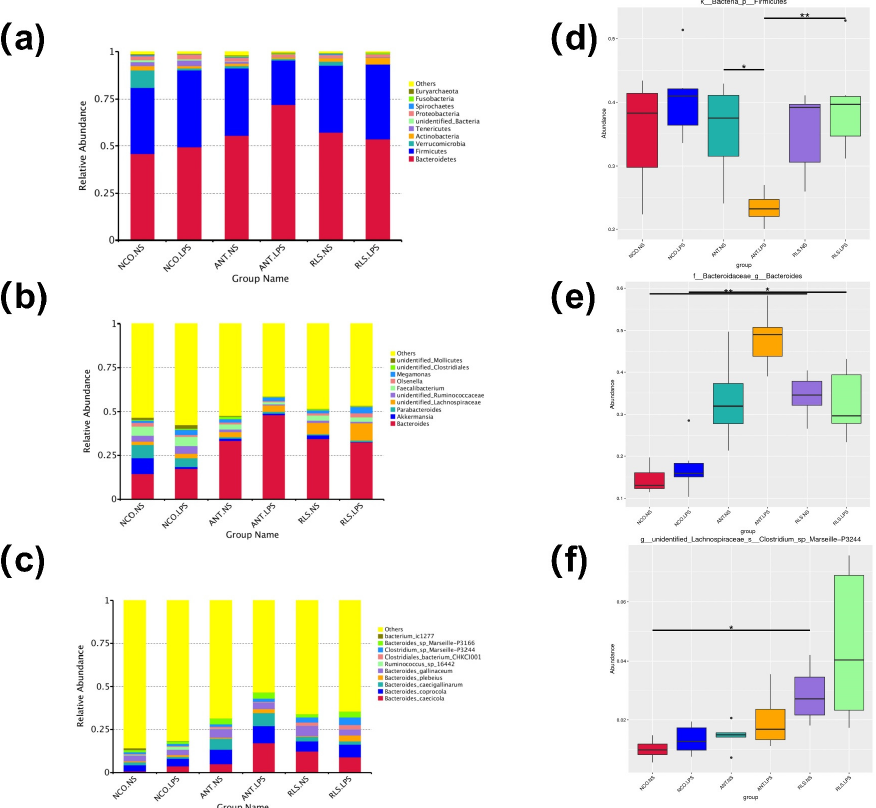
Figure 5. Effects of RLS on microbial community in caecum contents in broilers challenged with LPS. ( a – c ) The top 10 taxa by relative abundance within the microflora community (( a ): phylum; ( b ): genus; ( c ): species). ( d – f ) Species with significant inter-group differences ( d ): phylum; ( e ): genus; ( f ): genus. NS-NCO represents control broilers treated with normal saline; NS-ANT represents broilers treated with the antibiotic; NS-RLS represents broilers treated with rhamnolipids; LPS-NCO represents control broilers challenged with LPS; LPS-ANT represents broilers treated with the antibiotic and challenged with LPS; LPS-RLS represents broilers treated with rhamnolipids and challenged with LPS; * and different superscript letters indicate significant differences ( p < 0.05), ** represents very significant differences ( p < 0.01). n =